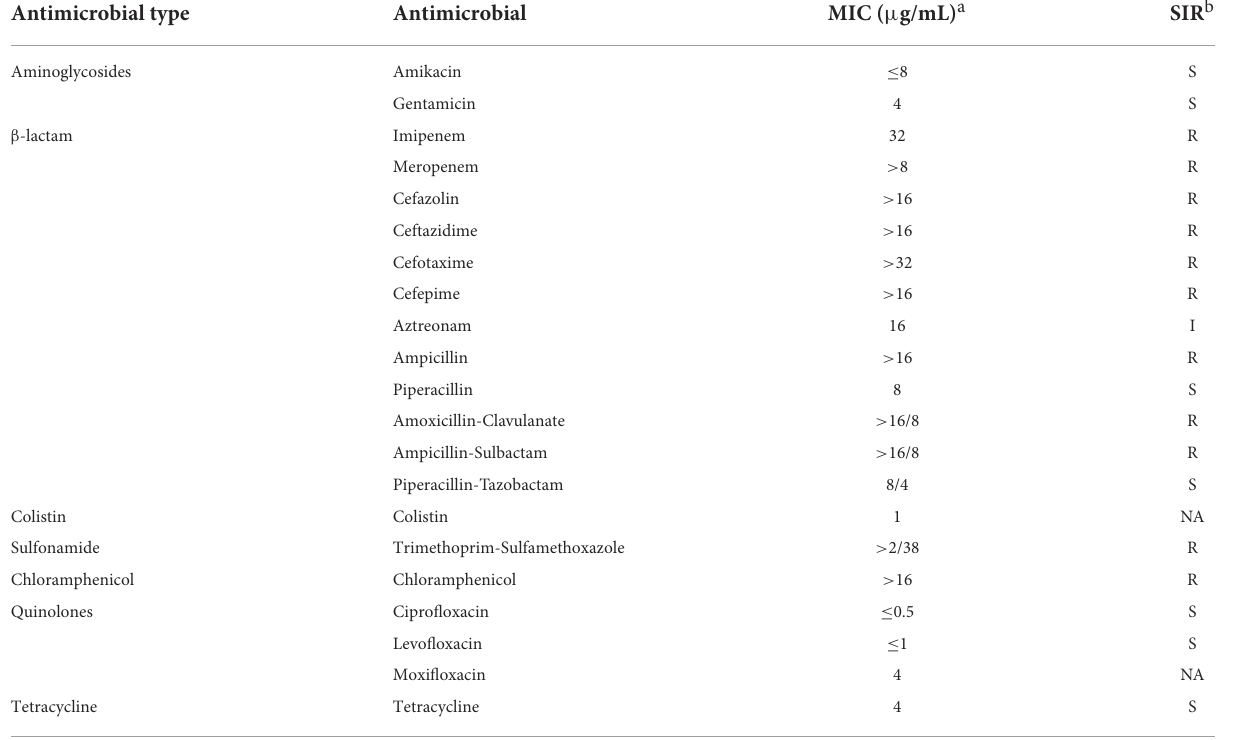
TABLE 1 Antimicrobial susceptibility of